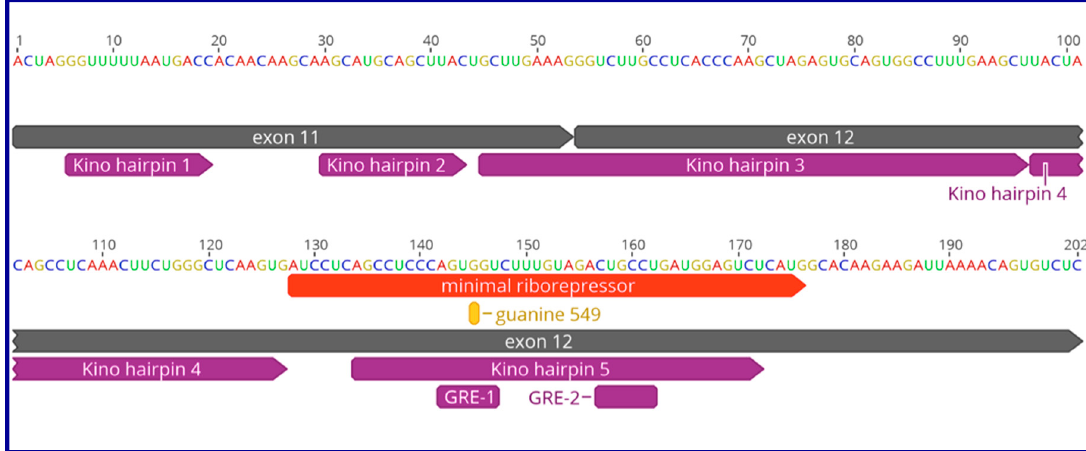
Figure 3. Kino et al. [71] is the first publication describing the “ribo-repressor” element formed at the 3’ end of the human GAS5 lncRNA, present in all transcript isoforms, featuring five calculated